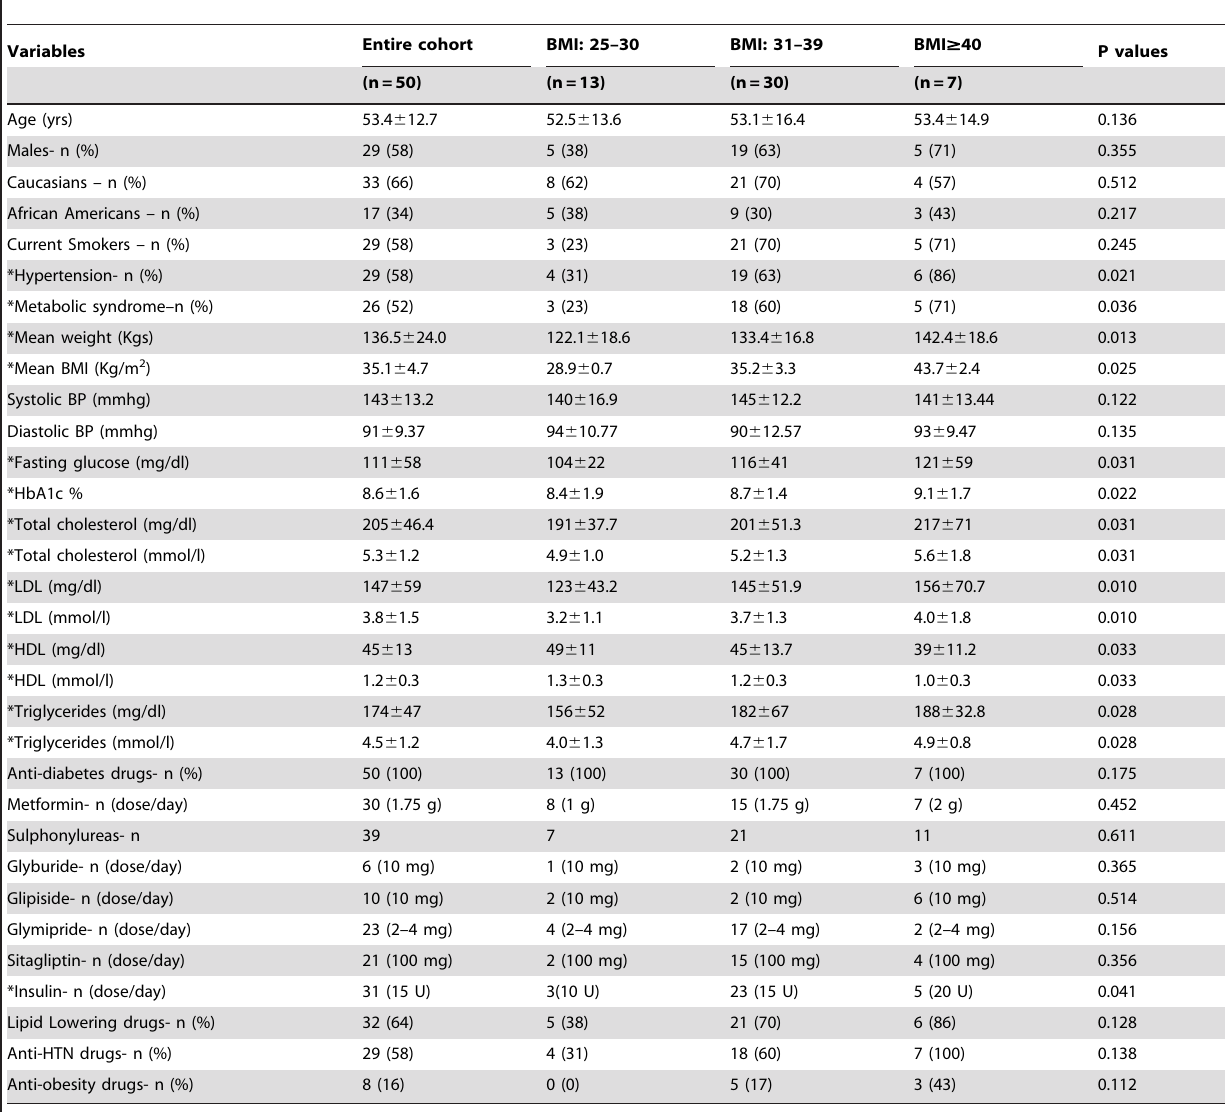
Table 2. Baseline characteristics of the study patients according to BMI